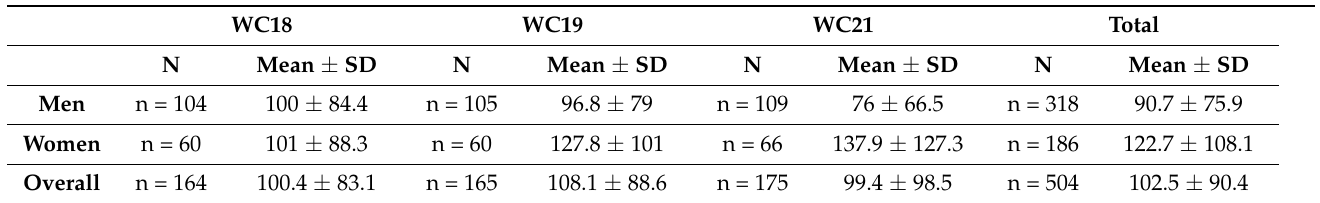
Table 6. Golden score (GS) period analysis in temporal terms (seconds-s) by the championship (WC18, WC19 and WC21) and sex (men vs. women) (n =